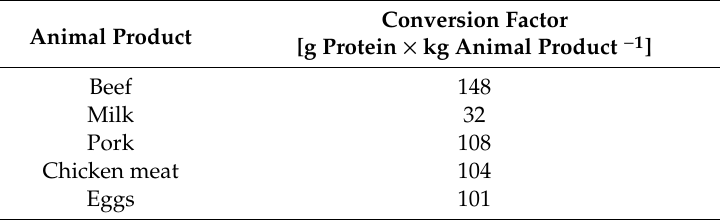
Table 5. Nutritional value in protein content of animal products. Calculations based on FAO [7] data for the 2013 average national consumption of product in kg cap − 1 year − 1 and protein consumption (g protein cap − 1 day − 1 ).